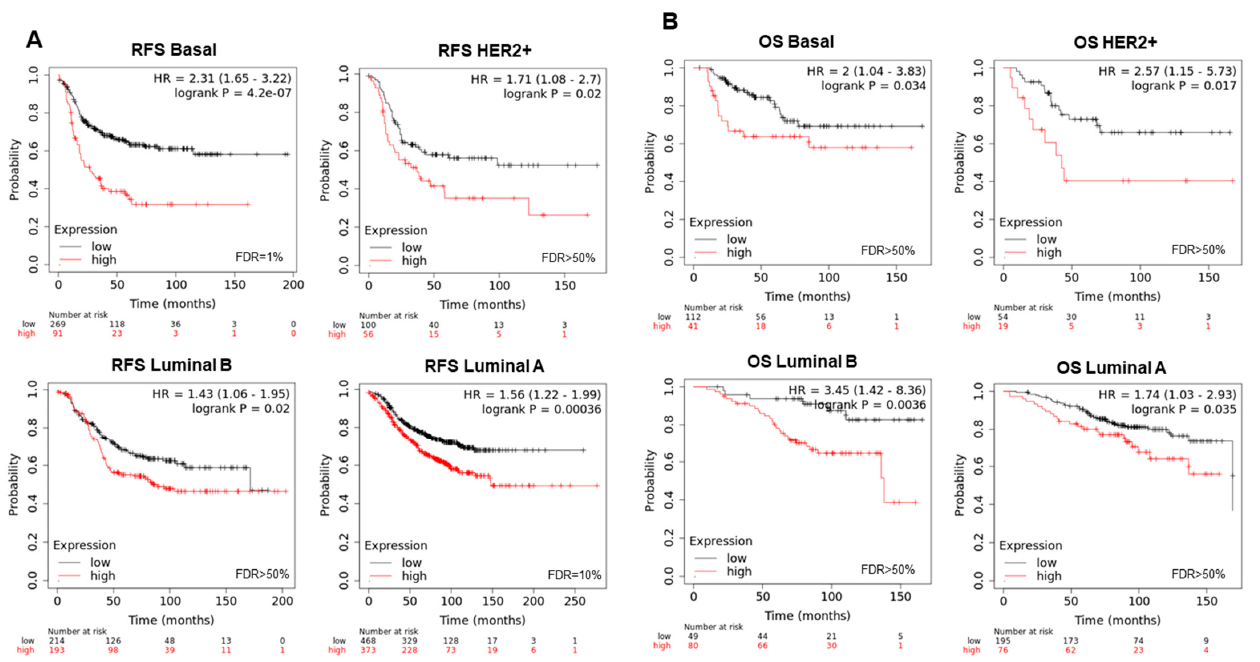
Figure 4. Association between gene expression and a worse survival across intrinsic subtypes of breast cancer. ( A ) Association with RFS and ( B ) OS with the expression of 19 selected genes ( BHLHE40, RFWD2, BRIP1, PRKDC, NBN, RNF8, FANCD2, RAD1, BLM, DCLRE1C, UBE2T, CSTF1, MCM7, RFC4, YWHAB, YWHAZ, CDC6, CCNE1 , and FANCI ) included in the response to DNA damage in all breast cancer